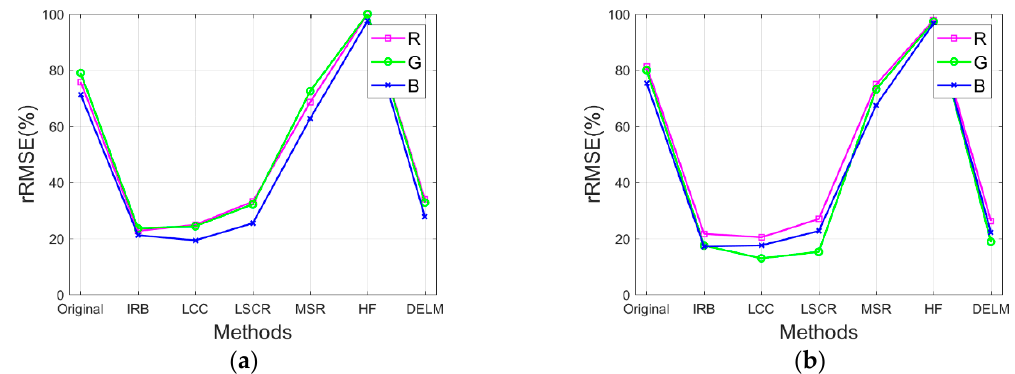
Figure 8. rRMSE of shadow compensation results for test images compensated before and after by various shadow compensation algorithms in terms of R, G, and B components. ( a ) Tripoli-1. ( b ) Tripoli-2.